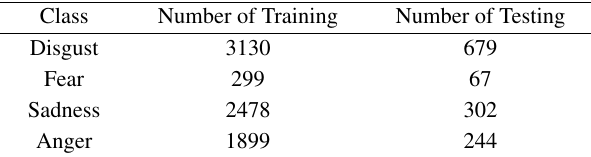
Table 2 Number distribution of each negative emotion